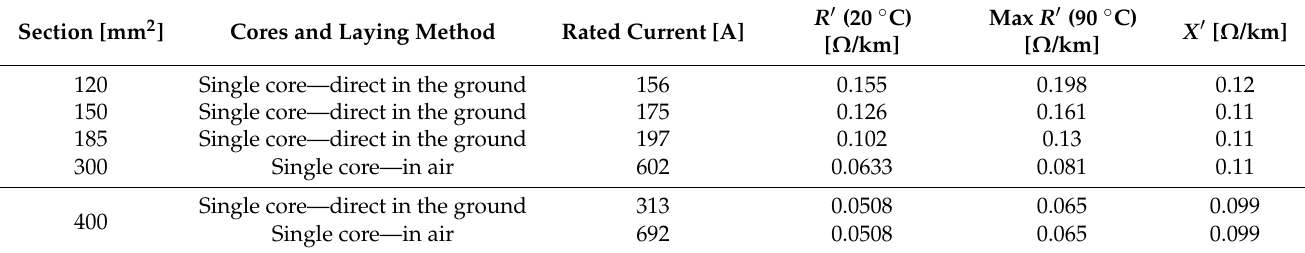
Table 10. Electrical data and technical characteristics assumed for 20-kV cables.